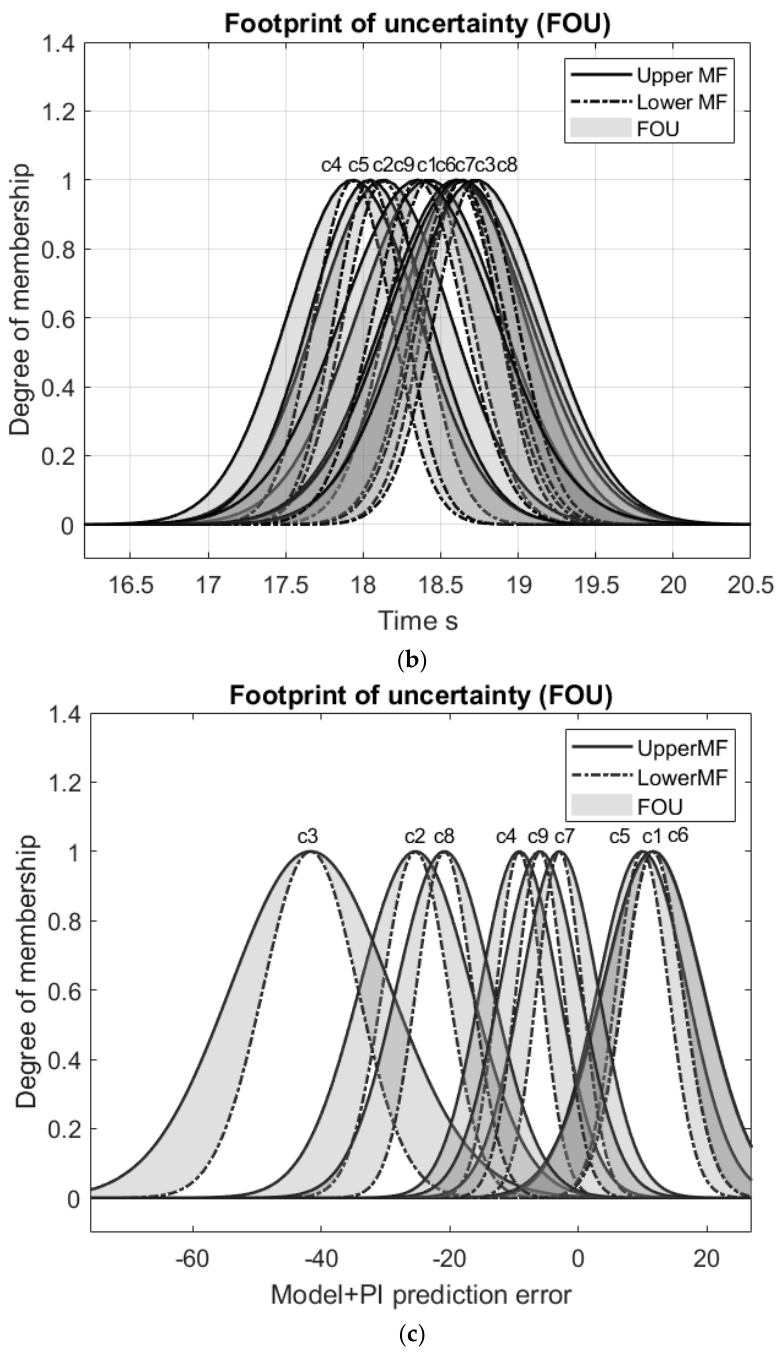
Figure 6. FCM 9-rule Mamdani GB input and output type-2 membership functions, ( a ) x 1 , ( b ) x 2 and ( c ) z .